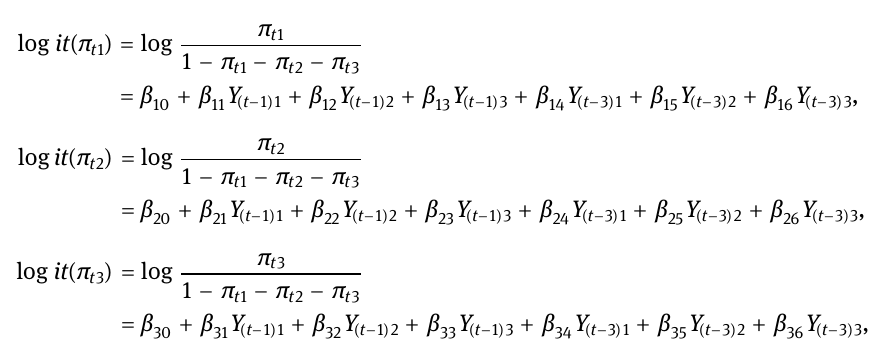
is monitored at = α 0.1 level of signi 34